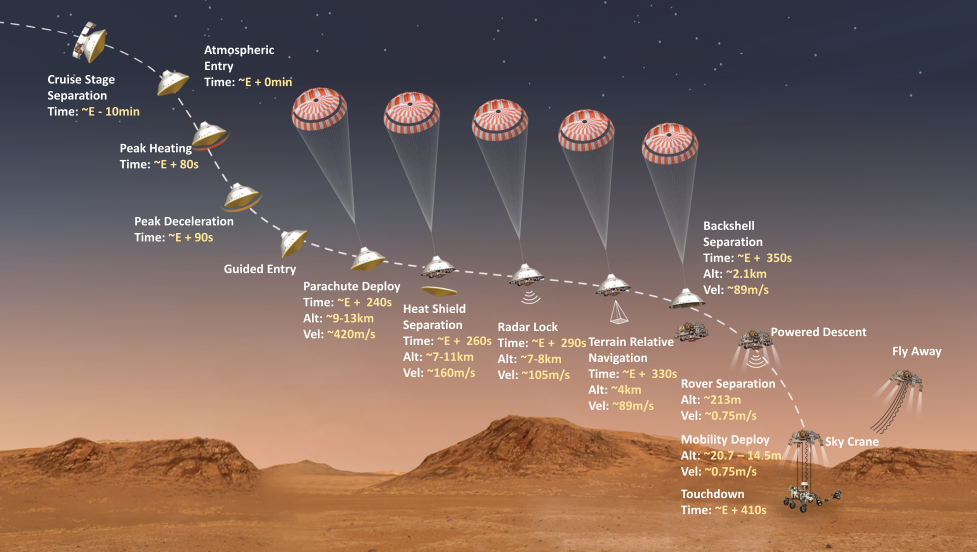
Figure 1. Entry, descent, and landing sequence at Jezero Crater for Mars 2020 mission by NASA (Image Credit: